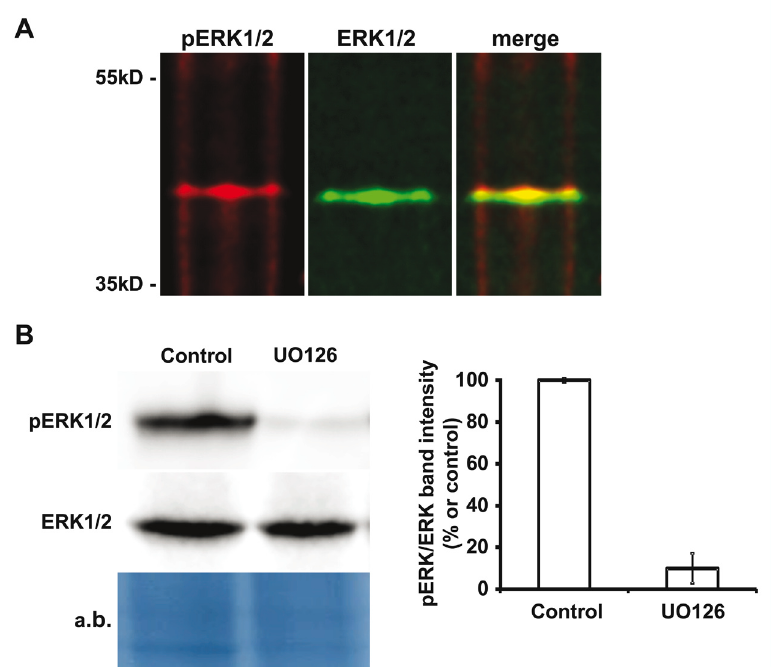
Figure 2. Detection of ERK activity in corals. ( A ) Fluorescent immunoblot revealing activated (pERK) and total forms of ERK (ERK) present in Stylphora pistillata nubbins. Molecular weight standards in kilo Daltons (kDa) are indicated on the left side of the figure. ( B ) Immunoblot performed with ERK and pERK antibodies on protein extracts from coral nubbins incubated in the absence (Control) or presence of the MEK inhibitor U0126. Densitometric analysis of activated ERK intensities is presented on the right of the figure. The amido black total protein staining of the western blot membrane is shown as a loading control. The medians and standard deviations of three independent experiments are presented (***, p<0.01,